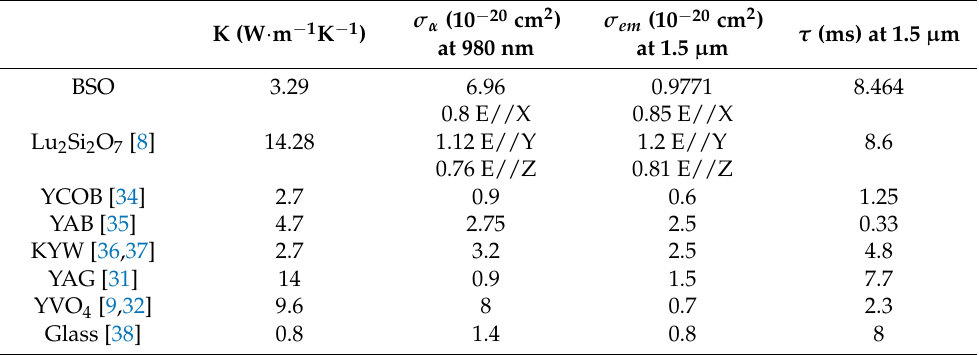
Table 2. Comparison of spectral parameters of Er/Yb co-doped laser crystals and glass [33] .